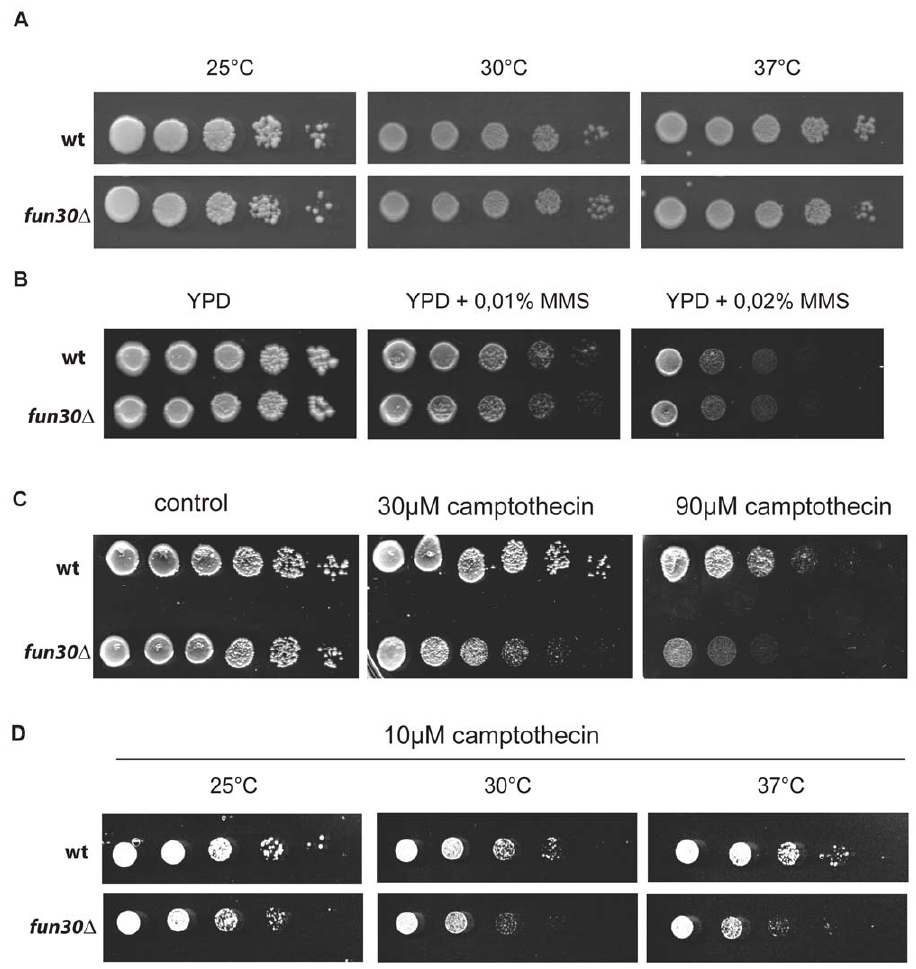
Figure 2. Deletion of FUN30 affects viability on camptothecin containing media. A. Strain Y00000 (wt) and Y00389 ( fun30 D ) were spotted after ten-fold serial dilution on rich medium agar (YPD) and grown for 2 days at the indicated temperatures. B. Same as in (A) but plates contained the indicated amounts of methylmethanosulfonate (MMS) and were incubated for 3 days at 30 u C. C. Same as in (A) but serial dilution was five-fold on YPD, 1% DMSO (control) or YPD, 1% DMSO and indicated amounts of camptothecin. Growth was at 30 u C. D. Same as in (A) but plates contained 10 m M camptothecin and were incubated 3 days at indicated temperatures.